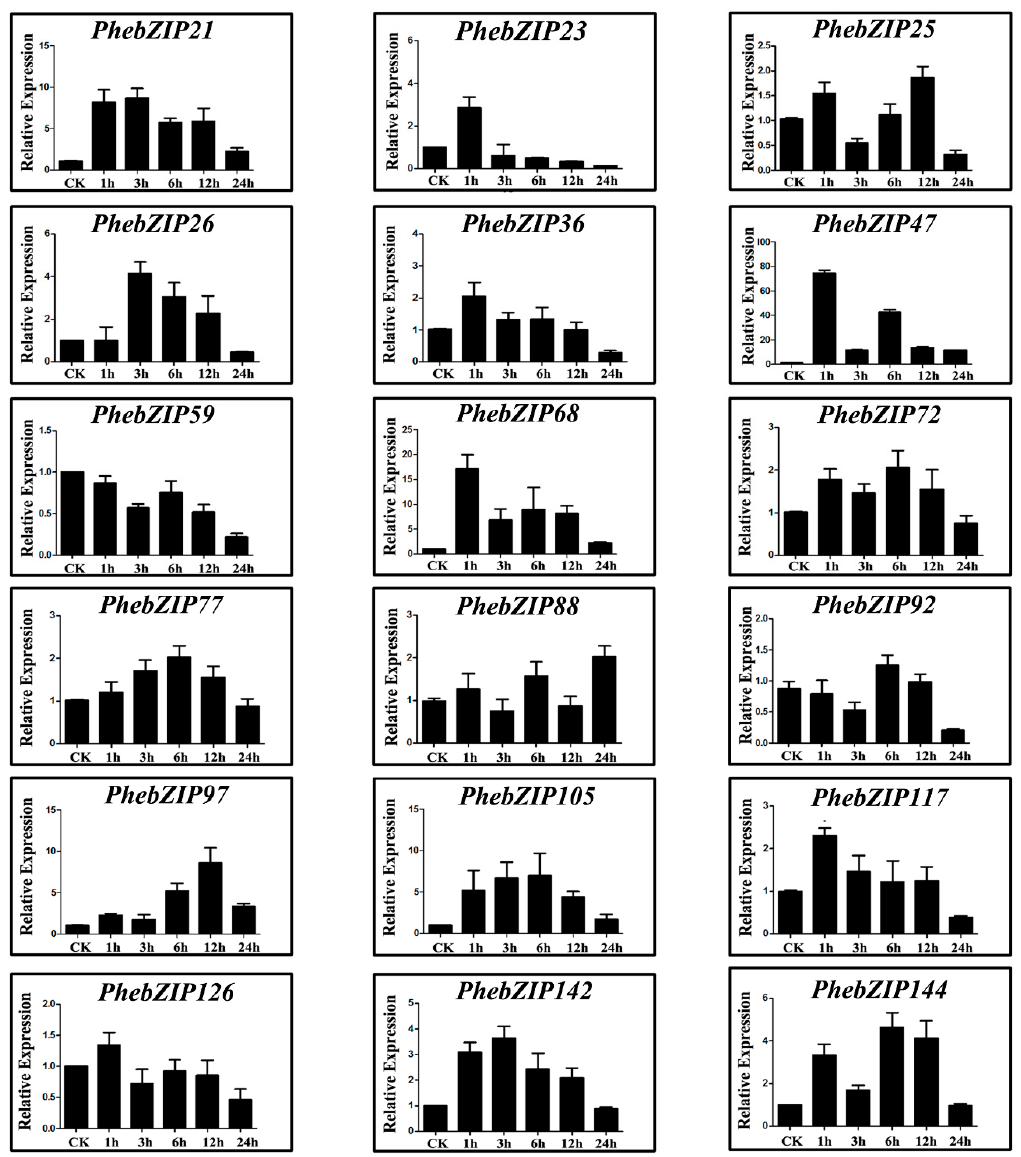
Figure 7. qRT-PCR expression analysis of selected PhebZIP genes following methyl jasmonate (MeJA) treatment. Relative expression levels of bZIP genes were examined by qRT-PCR and normalized with respect to the reference gene TIP41 under drought stress treatment. Bars represent standard deviations (SD) of three biological replicates. Y-axes indicate the scale of the relative expression levels. X-axes show time courses of MeJA stress treatments for each